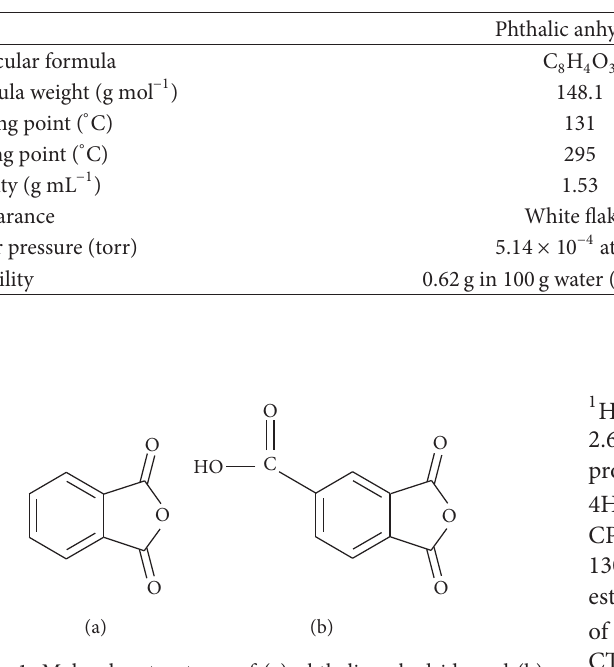
T 2: Some important properties of phthalic anhydride and trimellitic anhydride.